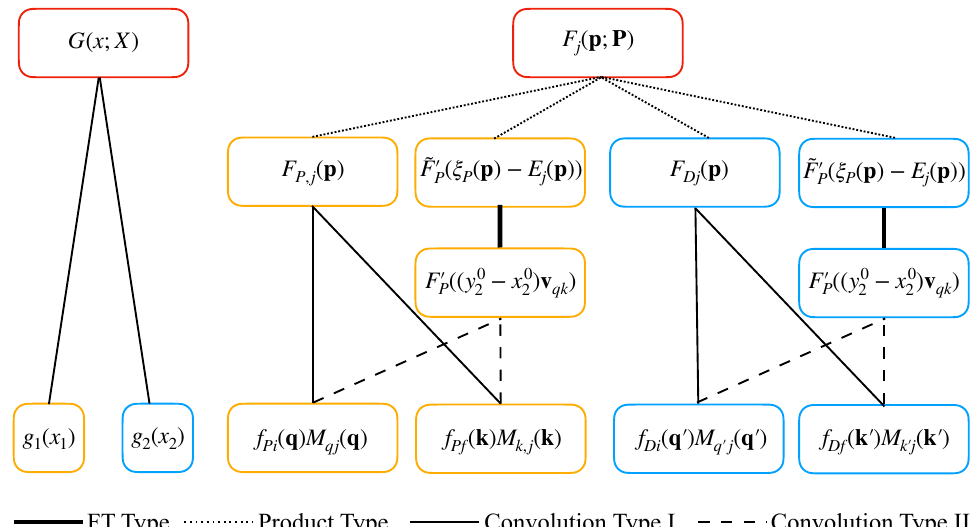
Figure 18 . The final (width of the) weighting functions ( G ( x ; X ) and F j ( p , P ) ) in terms of the wavepacket (size) of each of the external particles, and the spatial uncertainty (size) at the